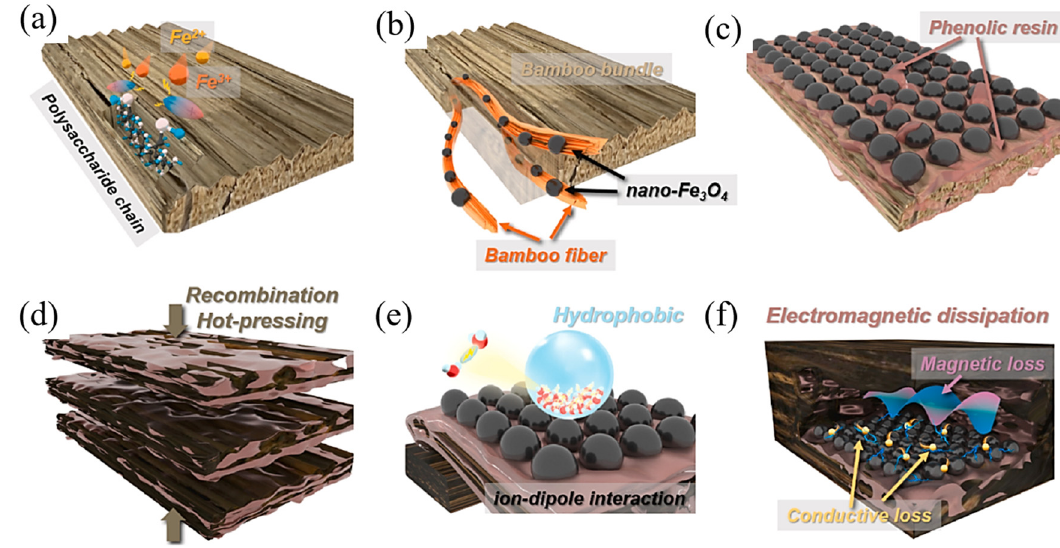
Figure 5: Schematic diagrams for ( a ) iron ions - impregnating bamboo bundle [ 100 ] , ( b ) nano - Fe 3 O 4 modi fi ed bamboo bundle [ 100 ] , ( c ) phenolic resin - impregnating bamboo bundle [ 100 ] , ( d ) recombination and hot - pressing treatment [ 100 ] , ( e ) hydrophobic behavior [ 100 ] , and ( f ) electromagnetic dissipation performance of nano - Fe 3 O 4 /bamboo bundles/phenolic resin oriented recombination ternary composite penal [ 100 ]